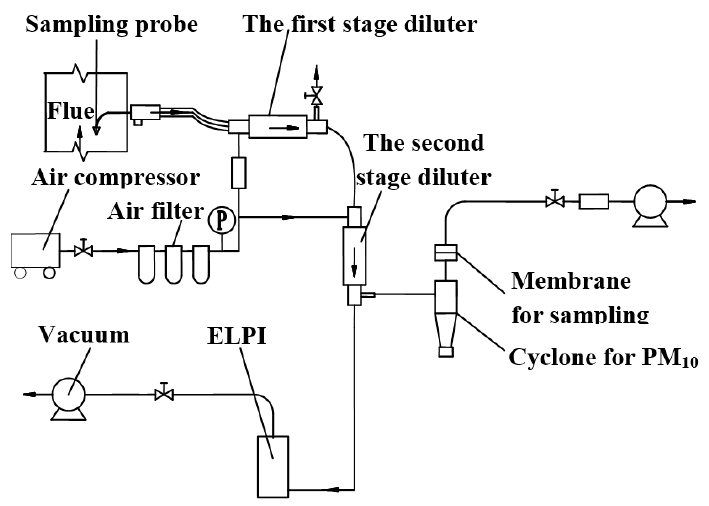
Figure 2. Schematic of fine particles sampling and measurement.